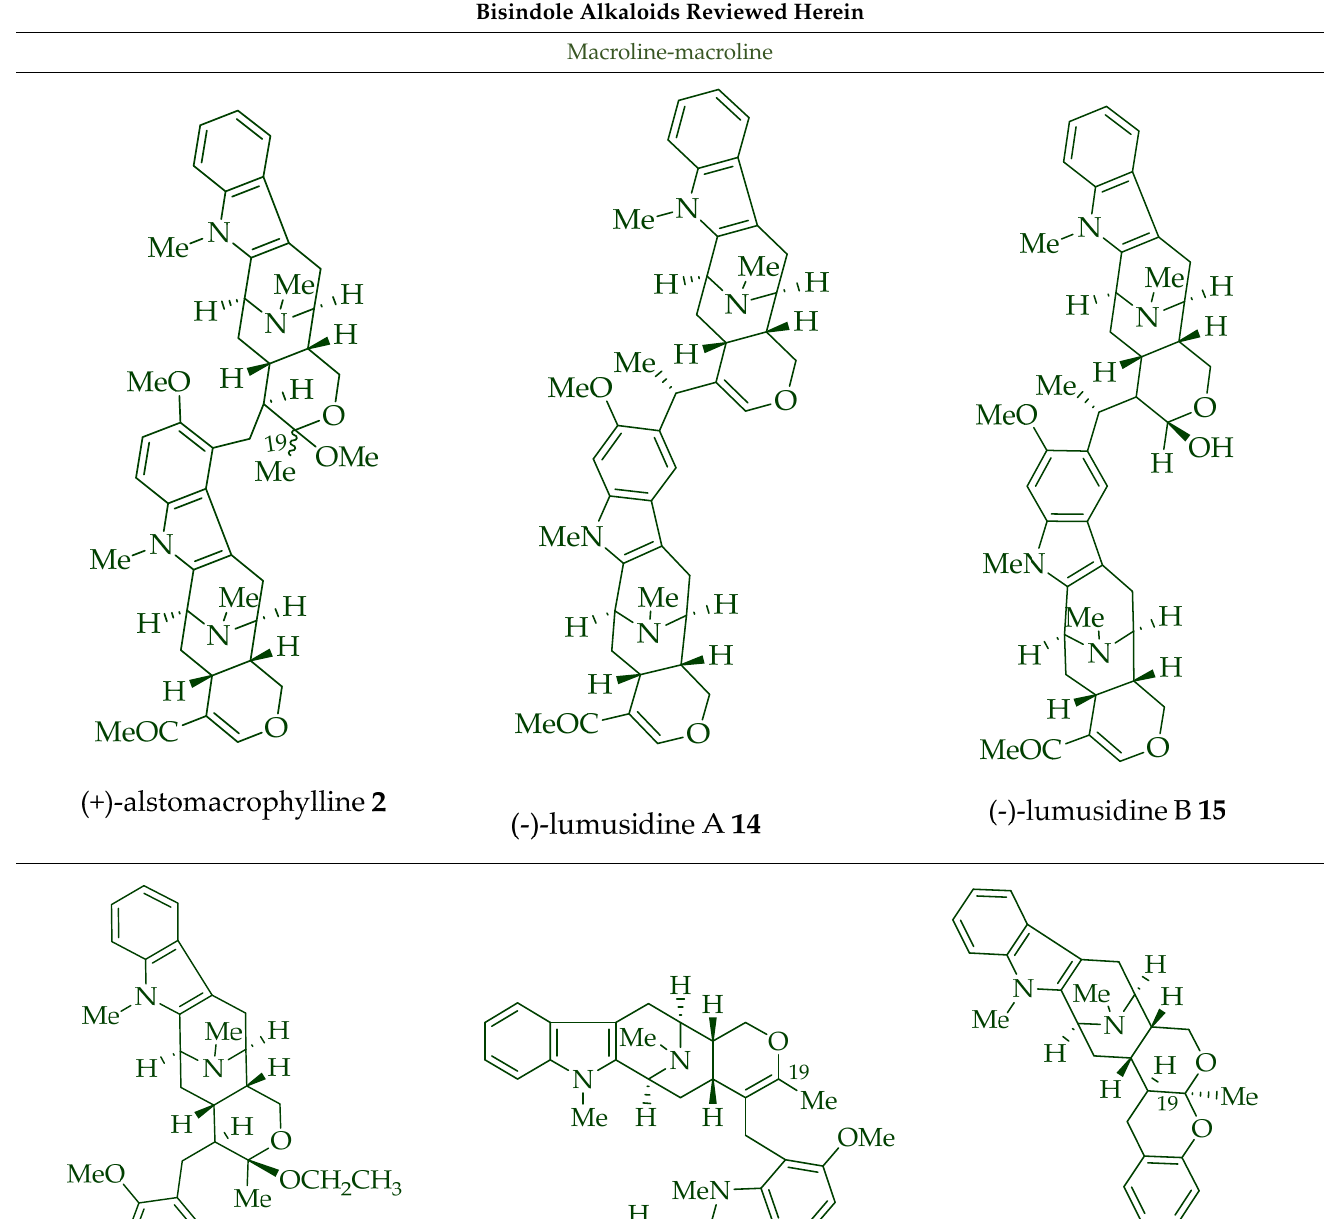
Table 2. Bisindoles from Alstonia species that are reviewed herein. Bisindole Alkaloids Reviewed Herein